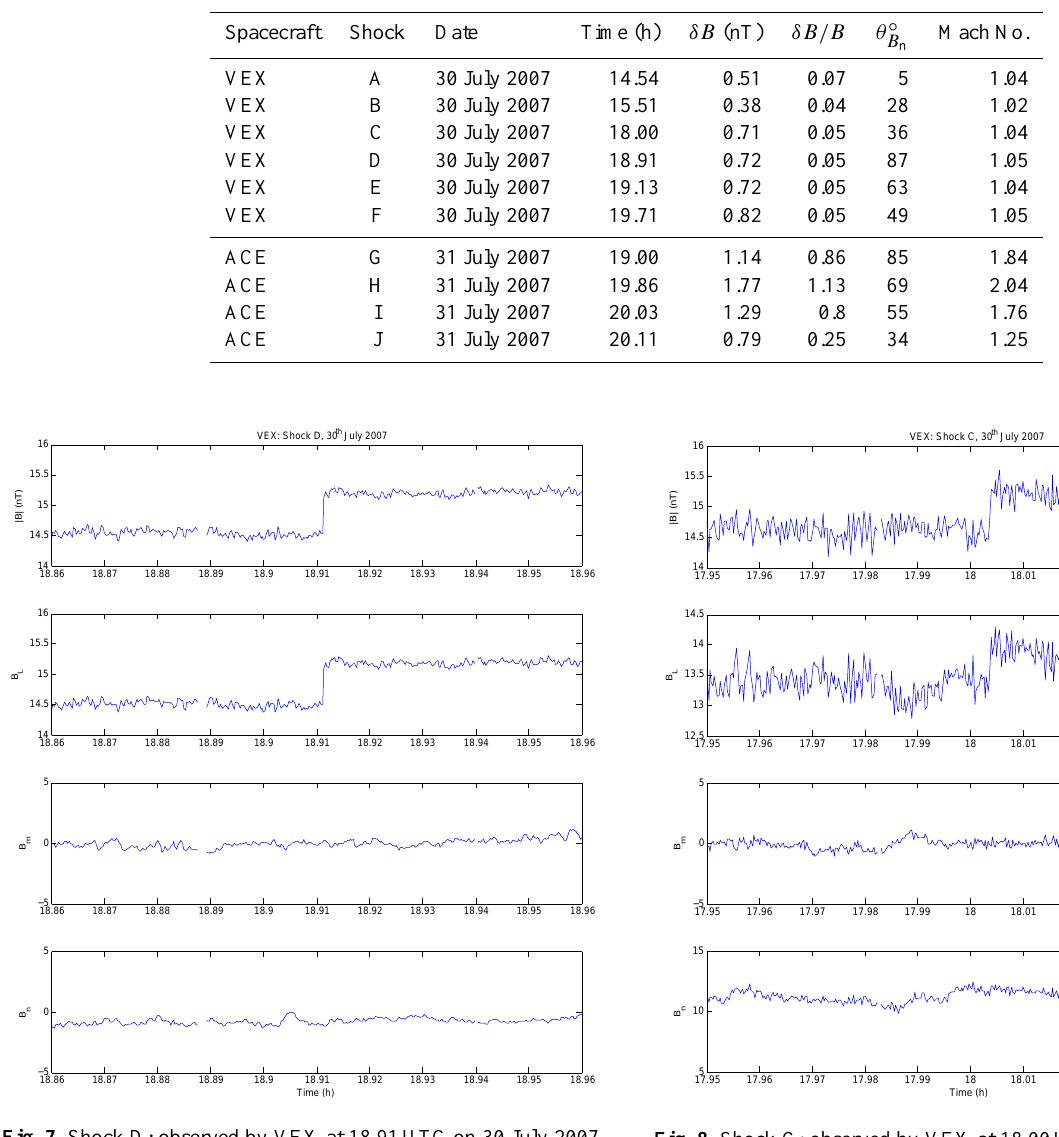
Fig. 8. Shock C: observed by VEX at 18.00UTC on 30 July